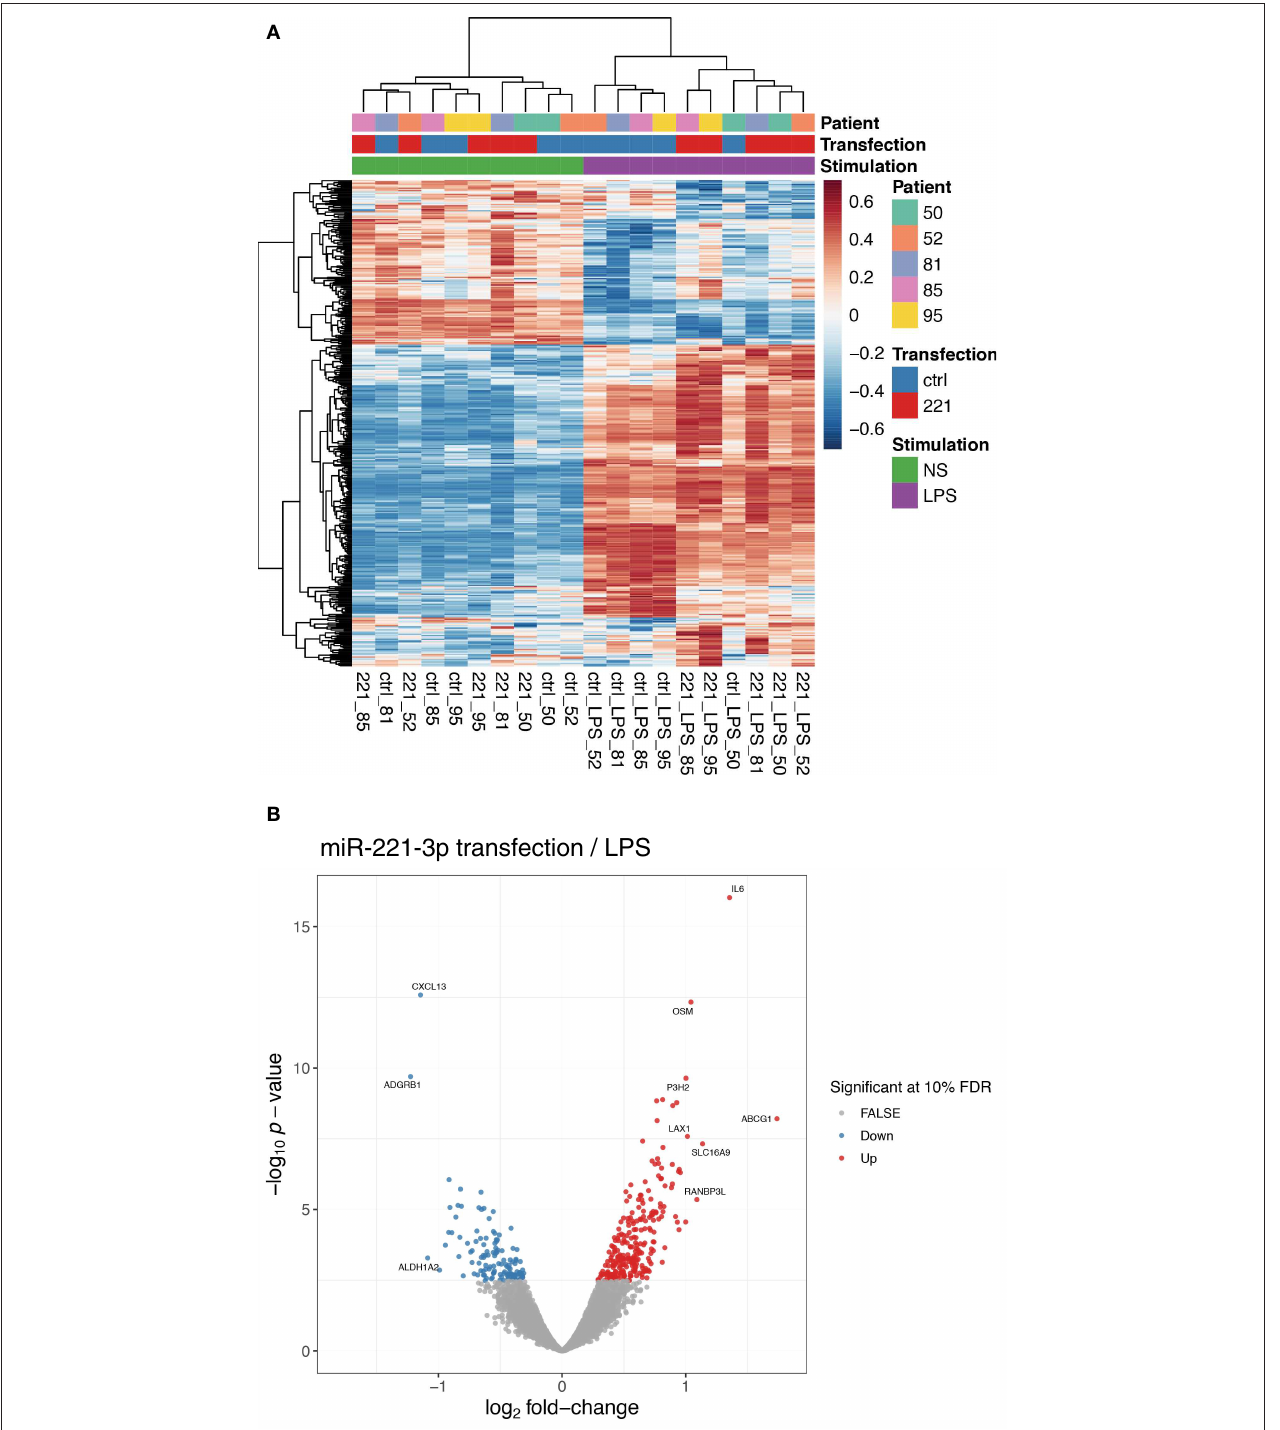
FIGURE 3 | Gene expression profile of M2-macrophages transfected with miR-221-3 p mimic plus/minus LPS stimulation. (A) RNA-seq was performed of in vitro generated M2-macrophages transfected with control miR (ctrl) or miR-221-3 p mimic (221) and stimulated with LPS for 8.5h or left untreated (NS). The heatmap displays the centered and scaled gene expression levels of genes differentially expressed between miR-221-3 p transfected and control cells in LPS-stimulated conditions. To better visualize the differences across transfected and control cells, the expression levels were corrected for donor-specific effects (see RNA-seq methods in the Supplementary File 1 ). (B) Volcano plot showing the differentially expressed genes between cells transfected with miR-221-3 p mimic and control cells in LPS-stimulated cells. Significant genes are colored in red (up-regulated) and blue (down-regulated). For clarity, only genes with an absolute log2-fold change larger than 1 are